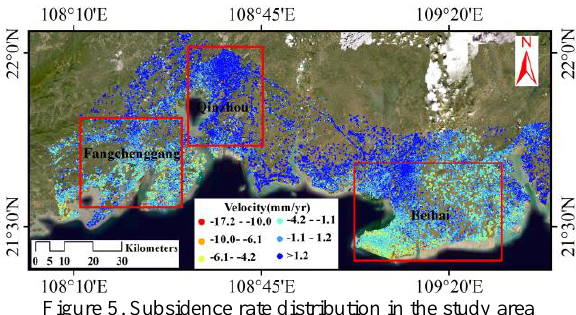
Figure 5. Subsidence rate distribution in the study area Inside the red rectangle are the three urban agglomerations in the Beibu Gulf region. (i.e., Beihai, Fangchenggang, and